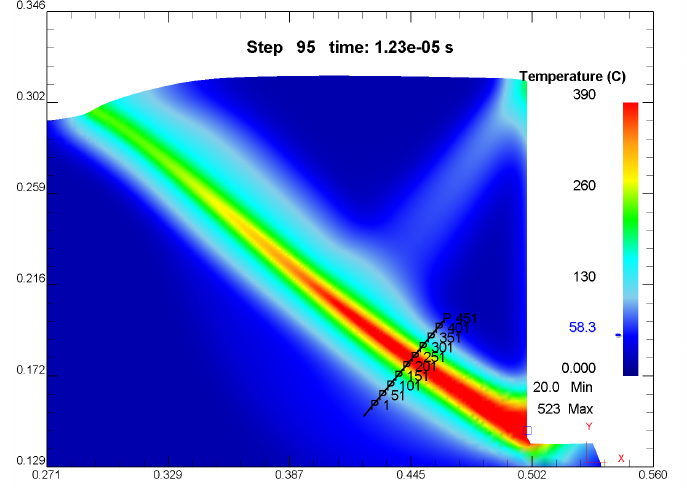
Figure 4. Calculation of state variables on a line approximately perpendicular to ASB. Simulation snapshot at t = 1.23 × 10 − 5